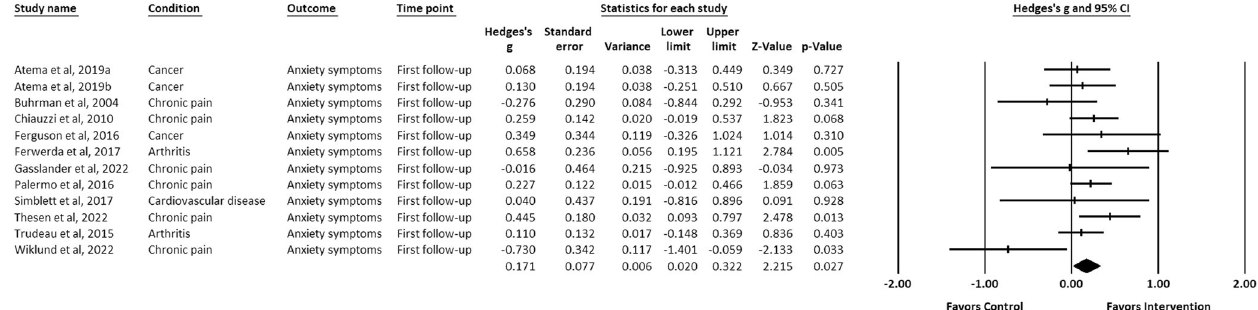
Fig. 6 Forest plot for effect sizes of IM-CBT on anxiety symptoms at fi rst follow-up.